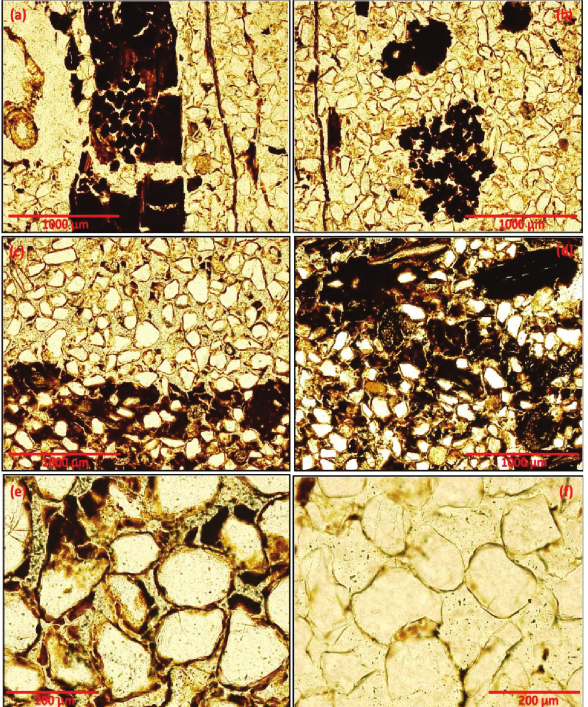
Figura 5. Fotomicrografias do perfil H13, horizonte Bhsj2, mostrando: (a) pelotas fecais na forma de agregados (De Coninck et al., 1974) no interior de uma raiz em diferentes estádios de decomposição; (b) pelotas fecais transformadas e coalescidas pela atividade microbiológica (Bullock et al., 1985), originando uma morfologia denominada de acumulação (De Coninck et al., 1974). Notar finos revestimentos predominantemente uniformes em cor e densidade nos constituintes grossos, típicos de iluviação; (c) remanescentes radiculares na base do horizonte Bhsj2 intimamente associados à matéria orgânica polimórfica de diferentes cores e densidades e paralelos à superfície do terreno, indicando decomposição radicular; (d) idem anterior, mais próximo à base do horizonte; (e) detalhes da matriz do horizonte Bhsj2. Notar revestimentos de diferentes cores, espessuras e densidades, possivelmente polimórficos; (f) parte superior do horizonte. Notar baixo conteúdo de finos, presença de grossos desprovidos de revestimentos e insertos numa matriz mônica-gefúrica, evidenciando ausência de iluviação de complexos